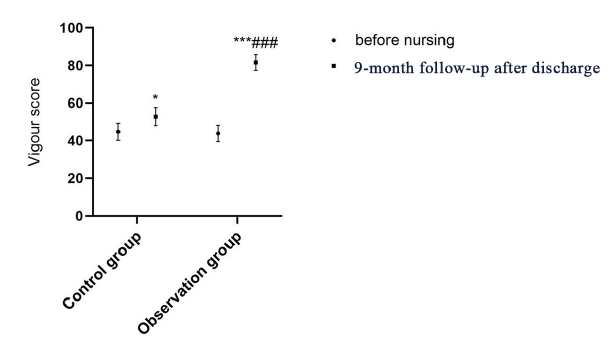
Fig. 2 - Comparison of body function score between two groups before and after continuing care. Compared with on admission within the same group, *P<0.05, ***P<0.001; compared with the control group after continuing care, ### P<0.001.